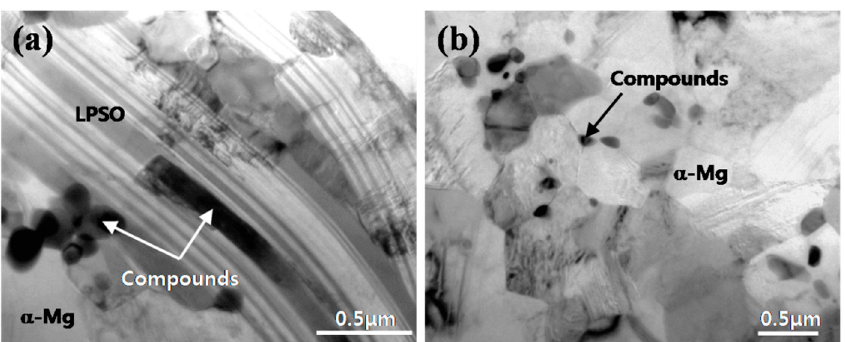
Figure 10. TEM micrographs of the extruded Mg 88.5 Zn 5 Y 5.0 Ce 1.5 : ( a ) morphology of LPSO phases and ( b ) morphology of compounds.